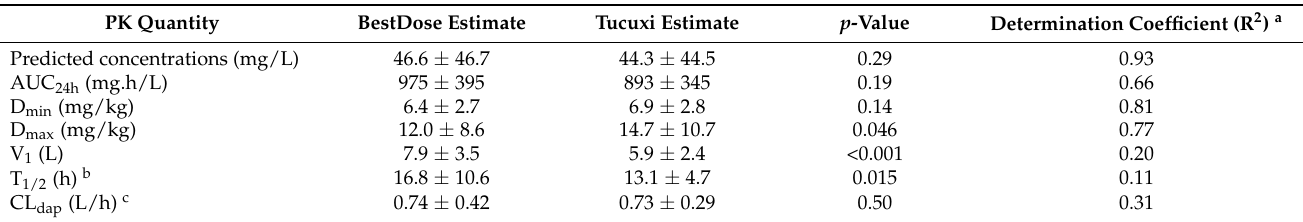
Figure 1. Observed versus model-based predicted concentrations of daptomycin in the learning dataset. Open circles and dashed lines, population predictions; black dots and dotted lines, individual predictions. Abbreviations: Ind., individual; Pop., population. Table 3. Comparison of individual PK estimates and parameters from BestDose and